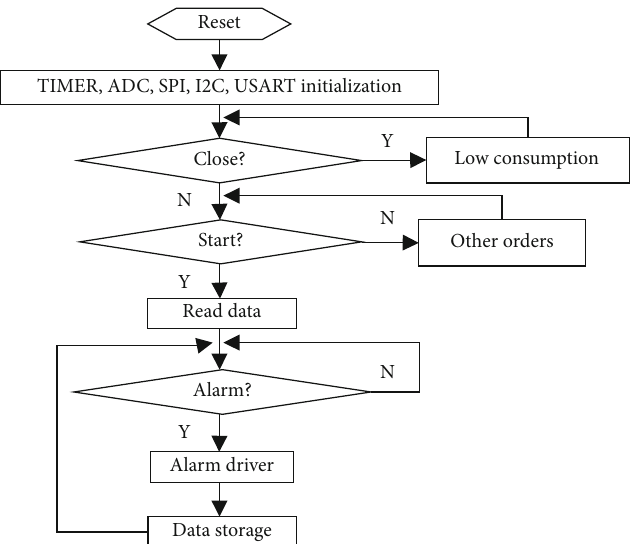
Figure 5: Program block diagram of the shock and vibration acceleration recorder.